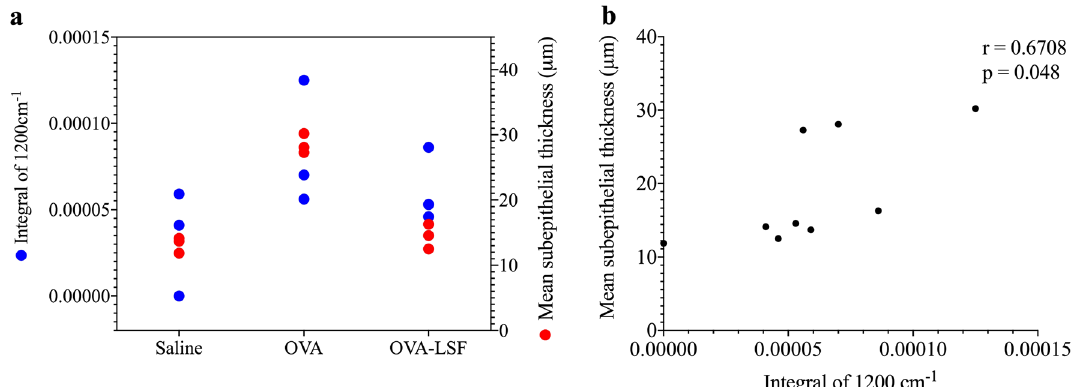
Figure 5. Comparison of collagen presented in the reversal model of allergic airways disease, based on the data obtained from histology (red) and S-FTIR spectra (blue). The mean subepithelial thickness calculated from a Masson’s trichrome stain and the integration of band 1,200 cm −1 calculated from a curve fitting analysis were used to identify collagen deposition in each method and are plotted together for comparison purposes (a) . A Pearson’s correlation was performed on the two methods (b) and found to have a statistically significant (p = 0.0479) positive correlation (r =